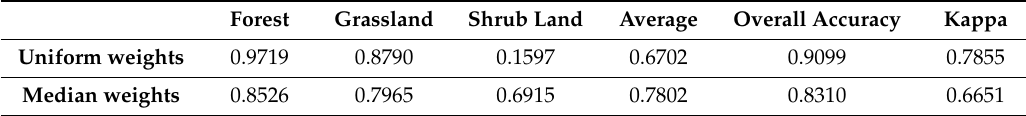
Table 9. Accuracy (uniform and median weights, Slovenia—3